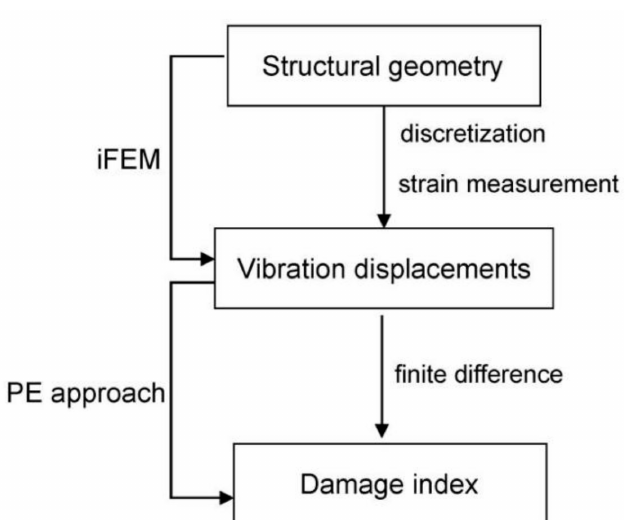
Figure 3. Flowchart of the inverse finite element method and pseudo-excitation (iFEM-PE)